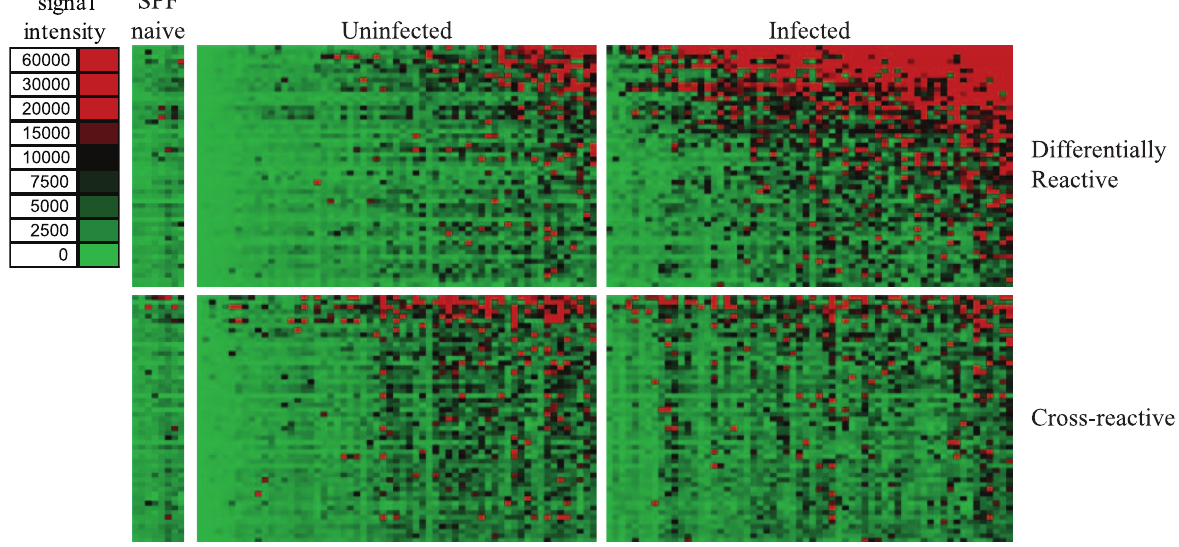
Figure 2. Probing a collection of B.henselae infected, uninfected, and SPF control cat sera. Arrays containing 1433 B. henselae proteins were probed with cat sera organized into 3 groups as described in the text. Heatmap showing normalized intensity with red strongest, bright green weakest, and black in between. Cat samples are in columns and sorted left to right by increasing average intensity to differentially reactive antigens, and antigens are listed in rows sorted by decreasing average seroreactivity of infected cats. Only seroreactive antigens are displayed (n=105). Seroreactivity is higher in the infected cats against differentially reactive antigens, but equally reactive in the cross-reactive antigen set.